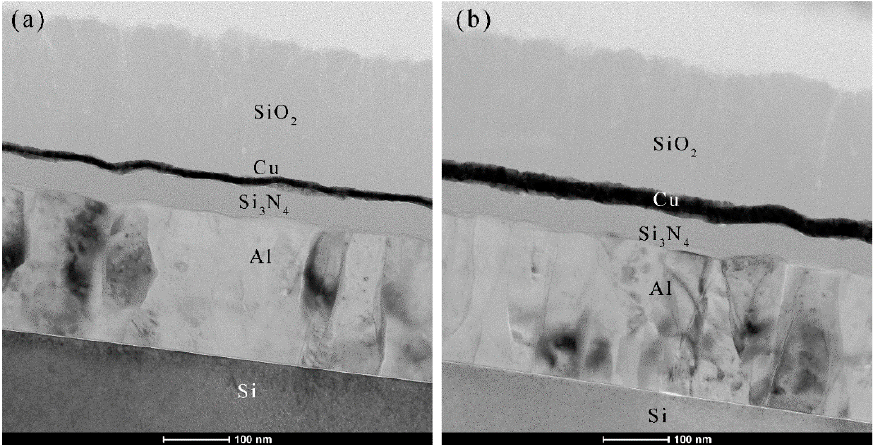
Figure 5. The Cross-sectional TEM images of ( a ) SiO 2 (200 nm)/Cu (12 nm)/Si 3 N 4 (50 nm)/Al (200 nm)/Si and ( b ) SiO 2 (200 nm)/Cu (25 nm)/Si 3 N 4 (50 nm)/Al (200 nm)/Si structures.